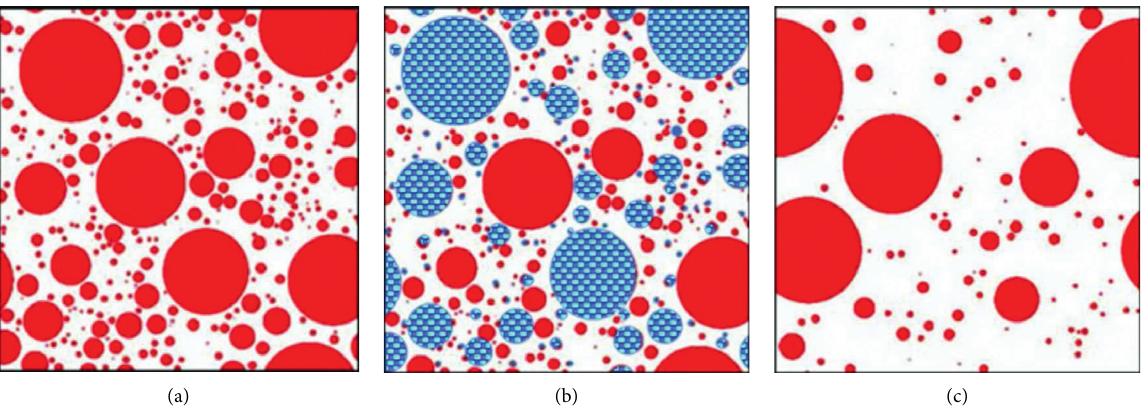
Figure 4: (a) Cement particles in OPC; (b) deflocculation; and (c) dilution of cement particles in HVFA system (red part, cement particles; blue patterned part, fly ash particles), reproduced from [31], with permission from Elsevier, 2021.